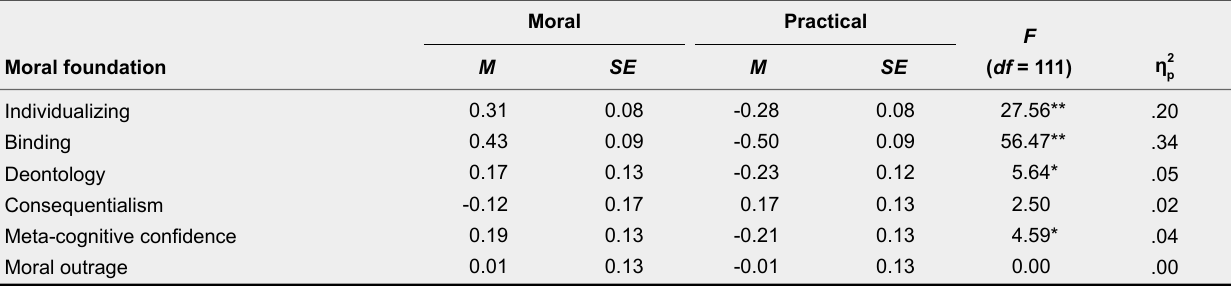
Means and SEs for All Dictionary Scores as a Function of Condition (Moral Versus Practical), Controlling for Initial Stance and Political Orientation in Study 3